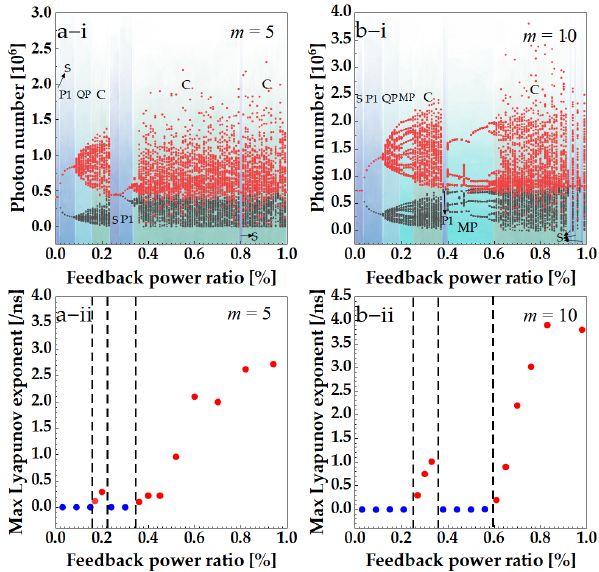
Figure 4. Bifurcations (i) and Maximum Lyapunov exponents (ii) of ICL output with external optical feedback under I = 1.1 I th , τ f = 2.4 ns. ( a ) m = 5, ( b ) m = 10.